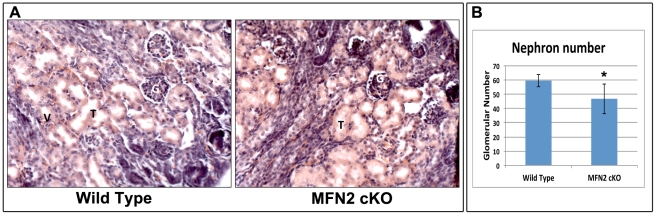
Effect of MFN2 conditional knockout on renal histology.(A) Wild type and MFN2 cKO kidney sections stained with hematoxylin and eosin; Tubules (T), glomeruli (G) or vasculature (V) appeared similar in both tissue sections. (B) Morphometric analysis of glomerular number in kidneys of wild type and MFN2 cKO littermates (n = 5/group). Data represent the mean and SD; * P<0.05.